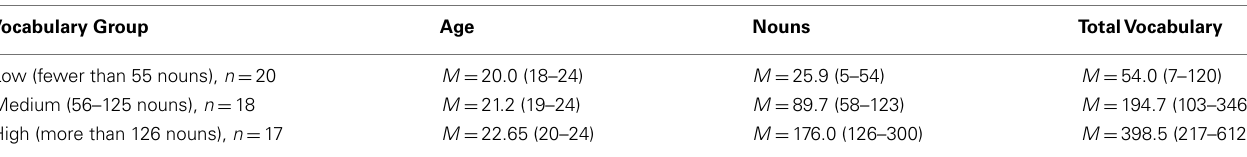
Table 1 | Number of participants in the three vocabulary groups in Experiment 1, and the mean ages, noun vocabulary, and total vocabulary sizes for three groups.